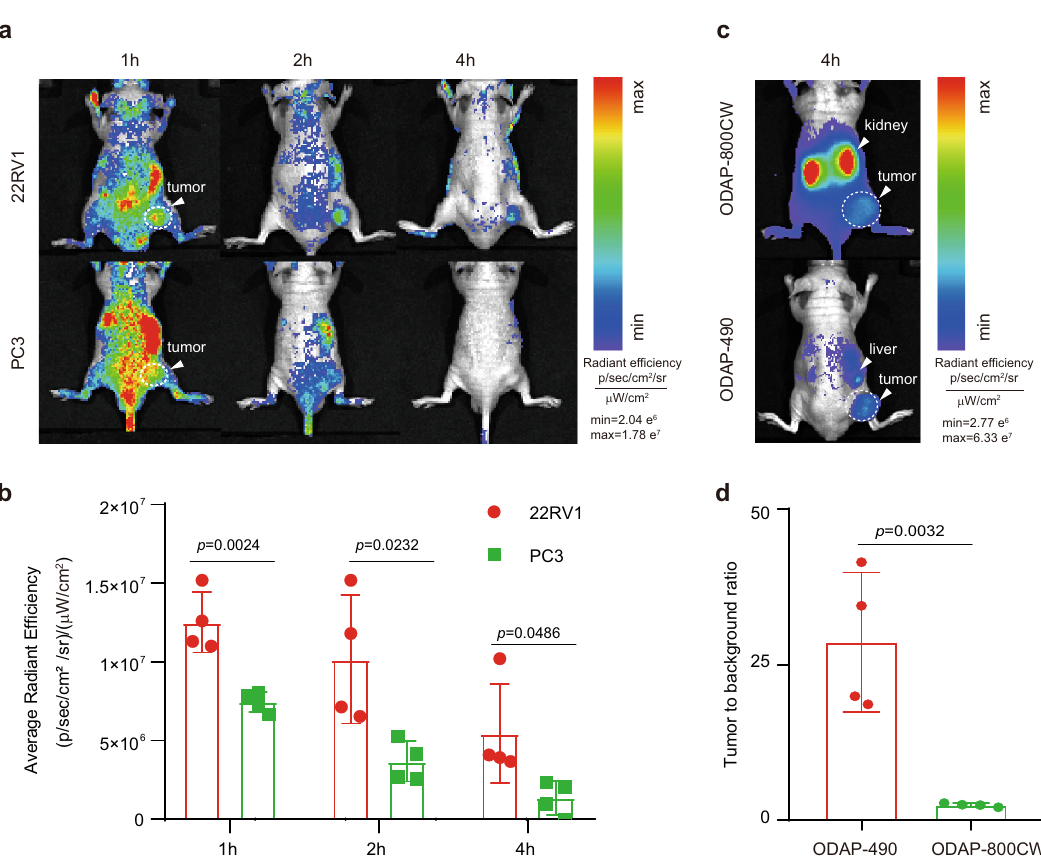
Fig. 5 In vivo imaging in mouse model of prostate tumor. a Fluorescence imaging of 22RV1 and PC3 tumors. Mice were intravenous injected with ODAP- 490 and images were acquired at 1 h, 2 h and 4 h. The white arrow and dotted circle indicate the location of tumor. b Quantitative analysis of fl uorescence intensity of 22RV1 and PC3 tumors in panel a . Data are presented as mean ± s.d. ( n = 4 biologically independent mice). Two-tailed unpaired Student t -test. c Fluorescence imaging of PSMA 22RV1 tumor at 4 h after injected with ODAP-490 or ODAP-800CW. The white arrow in the upper and lower panels indicates kidney and liver, respectively. The white arrow and dotted circle indicate the location of tumor. d Quantitative analysis of tumor-to-background ratio of 22RV1 tumors in panel c . The tumor area was delineated with bright fi eld and the same size of area was delineated on the opposite side as background. Data are presented as mean ± s.d. ( n = 4 biologically independent mice). Two-tailed unpaired Student t -test. Source data are provided in Source Data fi